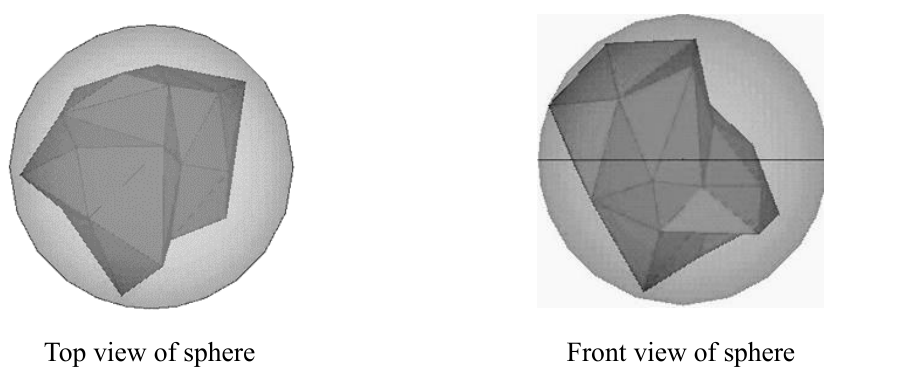
Fig. 6. A sphere enclosing stone aggregate.